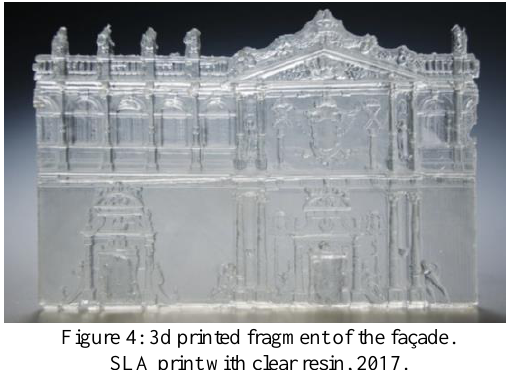
Figure 4: 3d printed fragment of the